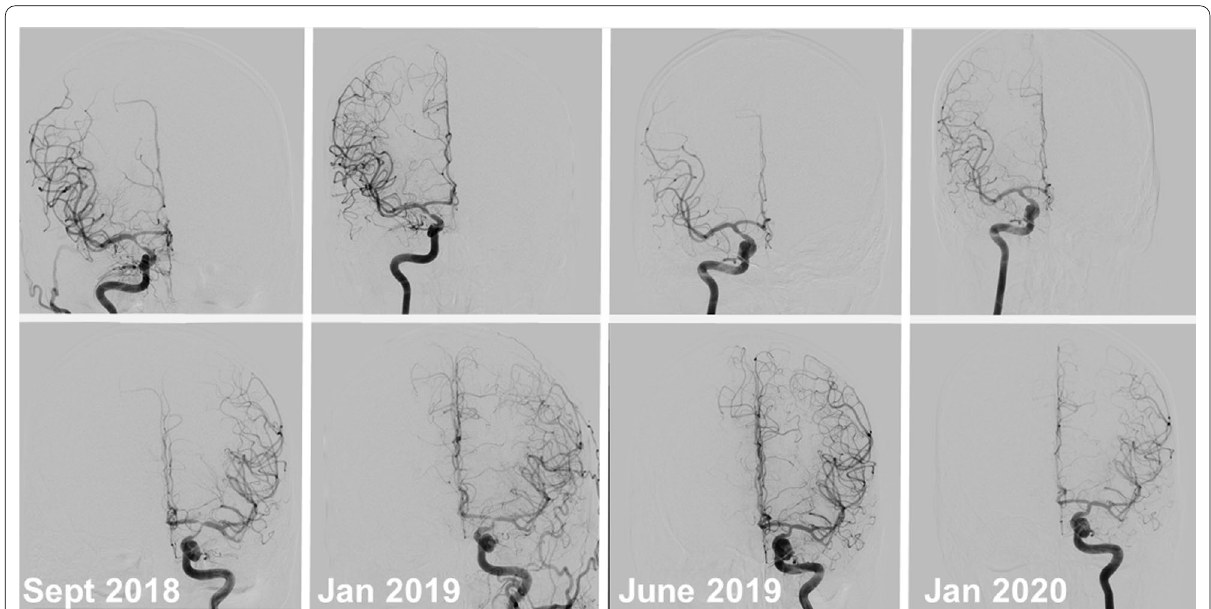
Fig. 1 Improvement of bilateral intracranial stenoses in a patient treated with prednisolone and